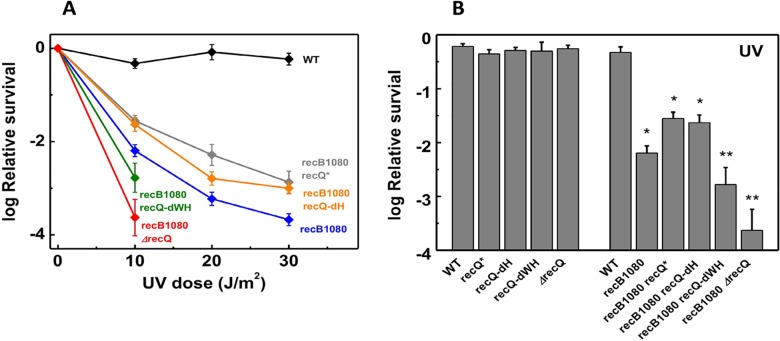
Loss of RecQ function further sensitizes recB1080 cells to UV-induced lesions.(A) UV survival (mean ± SE) of E. coli strains. Means ± SE for n = 5 biological replicates are shown. Low survival values (< 10−4) for recB1080 recQ-dWH and recB1080 ΔrecQ strains at UV doses above 10 J/m2 could not be accurately determined. Due to this condition and the generally low UV survival values measured in the recB1080 background, the standard dose-response model (Fig 2B) could not be applied. (B) Log relative survival values at 10 J/m2 UV irradiation (means ± SE). Asterisks indicate significant difference from the WT value (ANOVA, Tukey’s post-hoc test, p < 0.05). Double asterisks indicate further significant difference from each of the recB1080 recQ* and recB1080 recQ-dH strains (for recB1080 recQ-dWH), or from each of the recB1080, recB1080 recQ* and recB1080 recQ-dH strains (for recB1080 ΔrecQ). Multiple WT controls are shown alongside mutant values determined in the same experimental run. Data for non-recB1080 strains are from ref.[15].